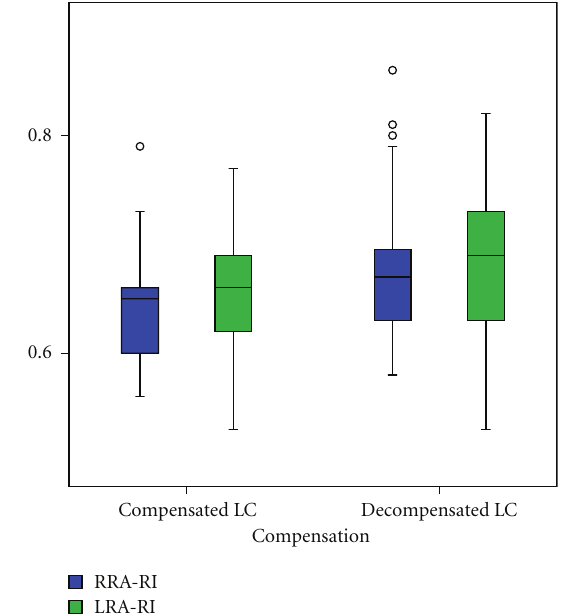
Figure 3: The values of RRA/LRA-RI in patients with compensated and decompensated liver